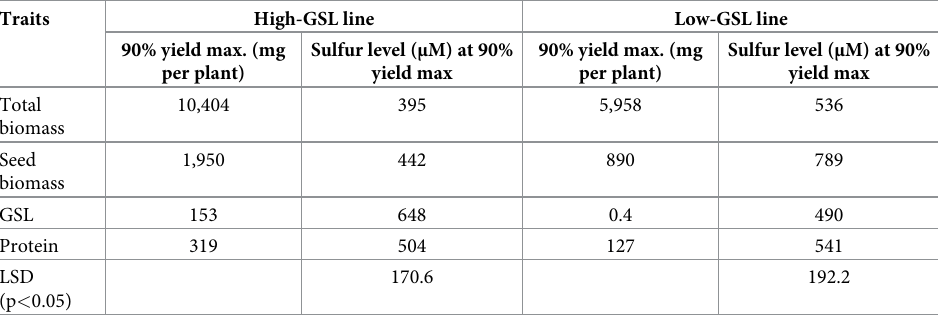
Table 1. Predicted values for 90% of maximum yield per plant for each trait, and predicted sulfur required to achieve this yield maxima, based on average trait data solved using modified Mitscherlich function.